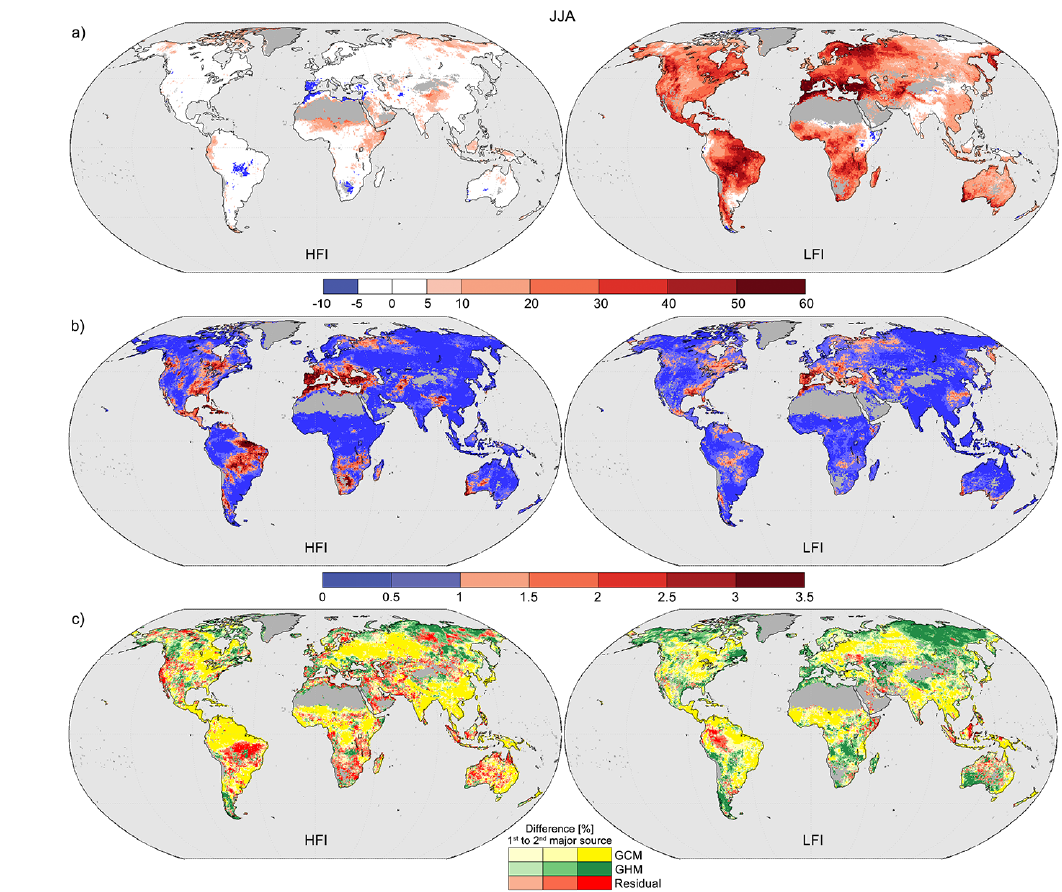
Figure 4. As Figs. 1 and 3, for the season